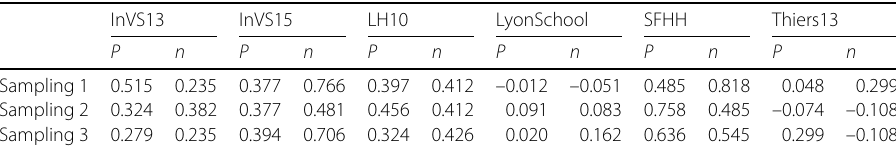
Table 6 Comparison of the vaccination strategy rankings InVS13 InVS15 LH10 LyonSchool SFHH